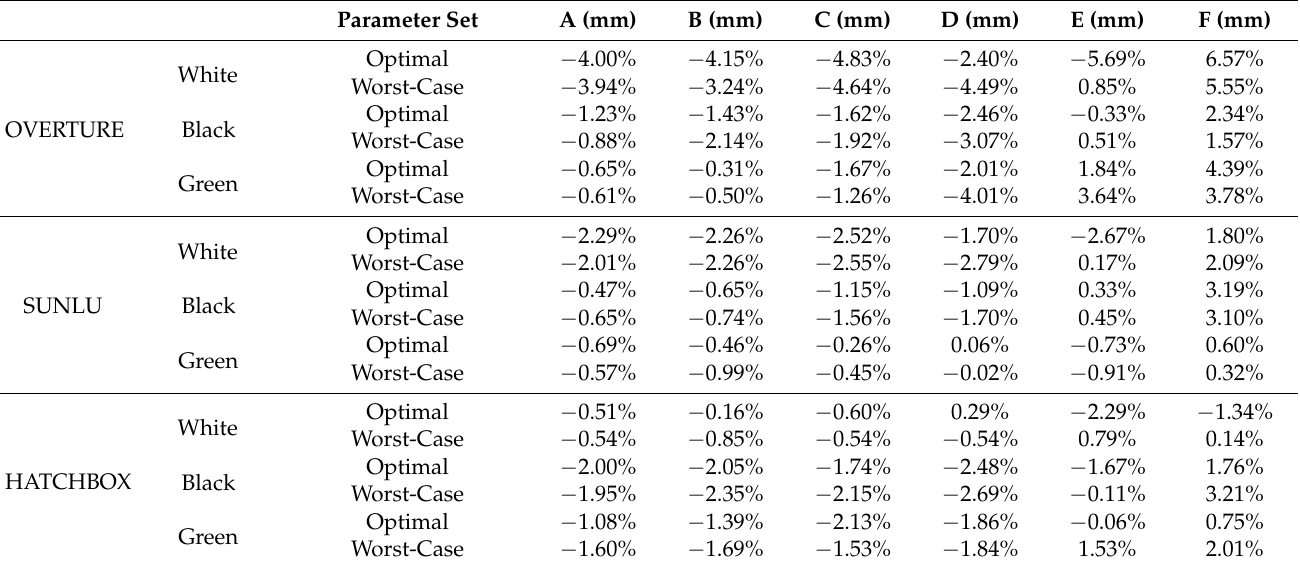
Table 7. Percent differences in the tensile specimen dimensions (with original units provided) between the annealed and as-printed conditions for each filament for both the optimal and worst-case parameter sets.